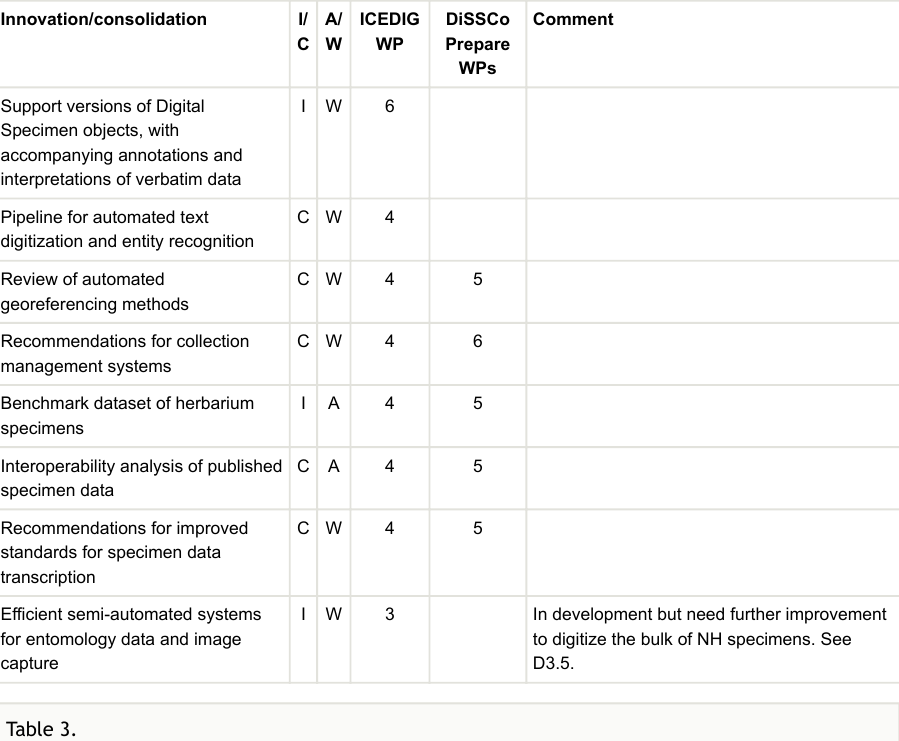
Innovation and consolidation in culture, skills and capacity